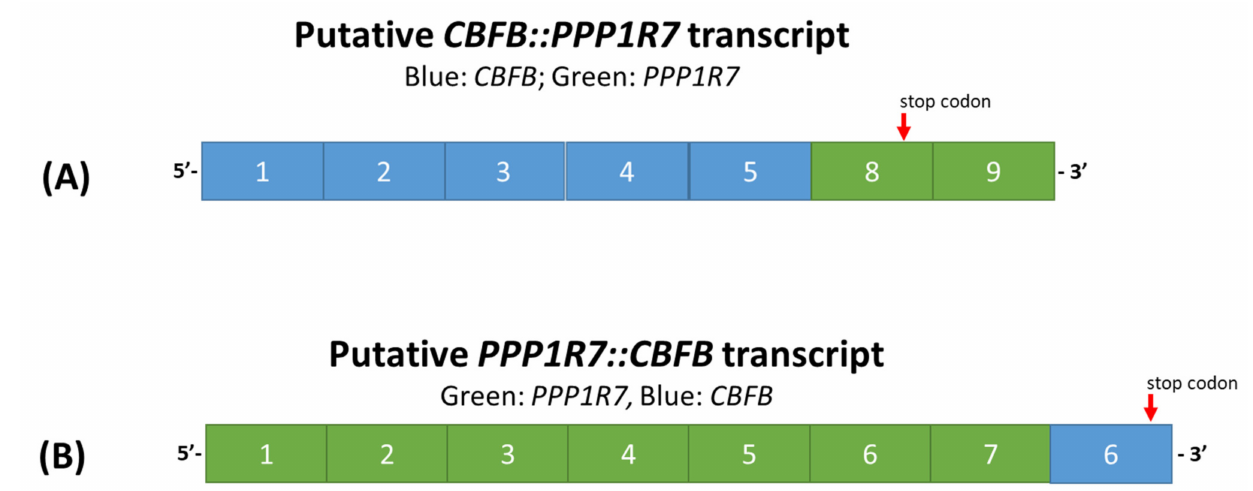
Figure 5. The putative CBFB::PPP1R7 ( A ) and PPP1R7::CBFB ( B ) transcripts.